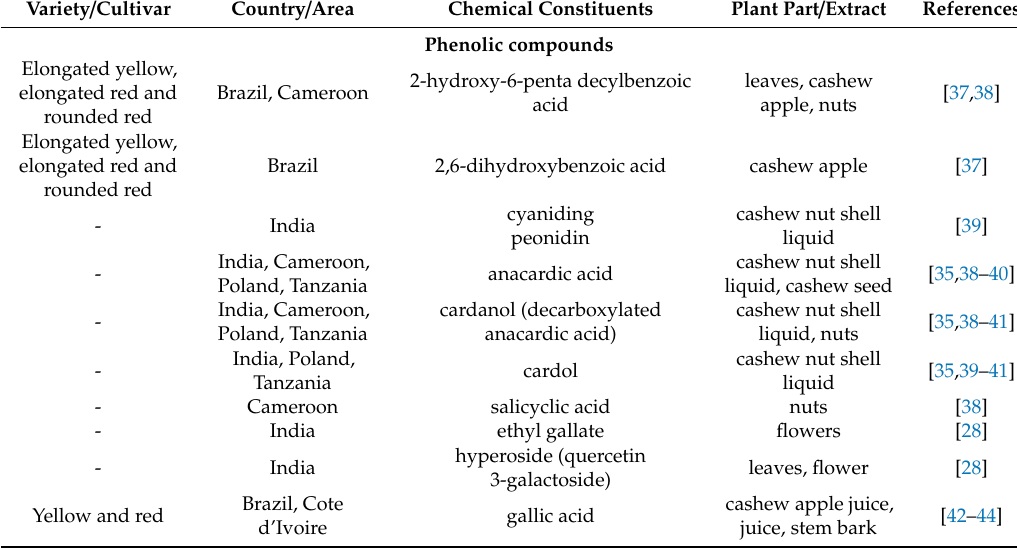
Table 6. Phenolic and carotenoids composition in Anacardium occidentale